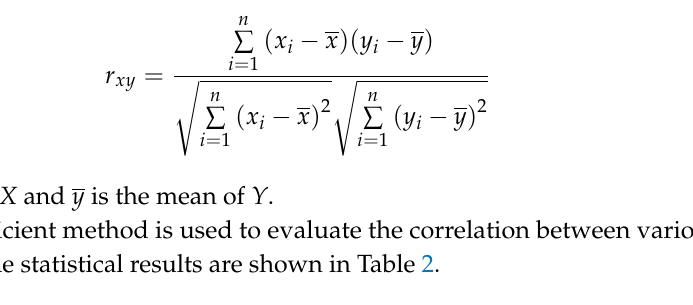
Table 2. The Pearson coefficients between variables and photovoltaic